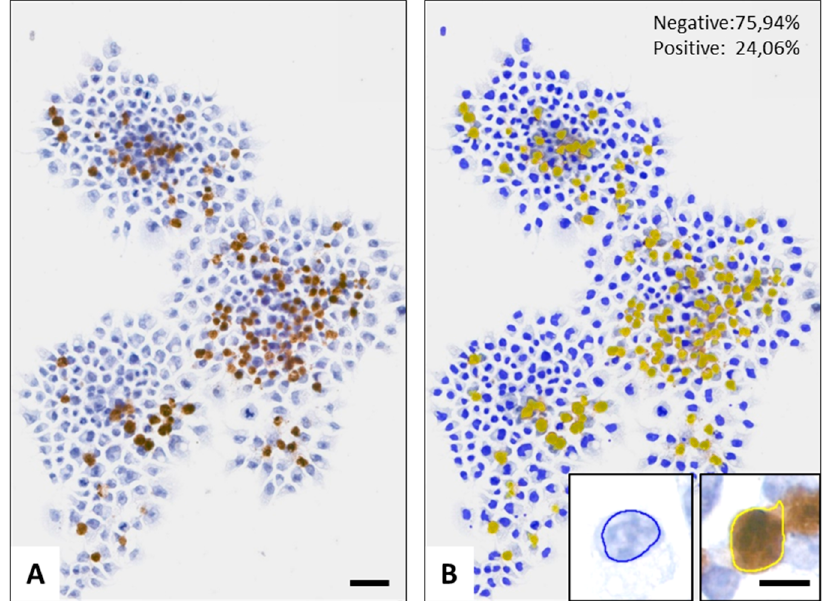
Figure 6. Demonstration of digital image analysis using the cleaved caspase-3 immunoreaction in R + mEHT treated Panc1 culture as an example. The NuclearQuant module of the QuantCenter software allowed the segmentation and counting of brown immunopositive cells ( A , scale bar: 50 µ m) and to determine their proportion to the whole population stained using hematoxylin. The accurately selected masque highlights positive (yellow labels) and negative (blue labels) cells shown also at high power in insets ( B , scale bar: 10 µm).